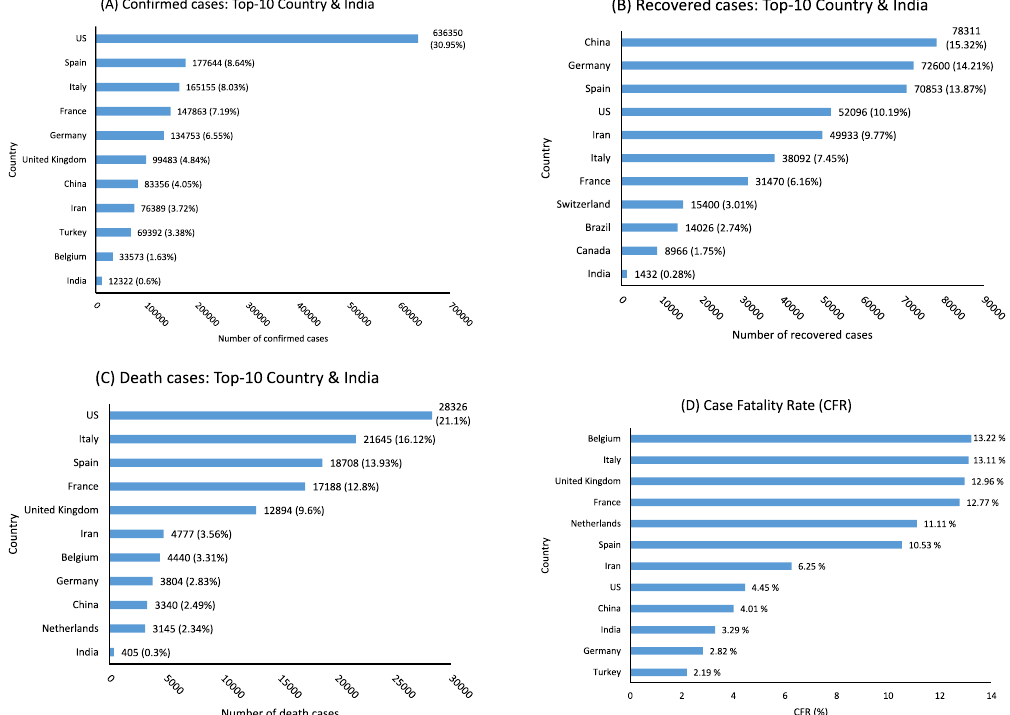
Fig. 3. Comparison of COVID-19 cases and CFR of top-10 country with India as of April 15, 2020; (A) confirmed cases, (B) recovered cases, (C) death cases, and (D)